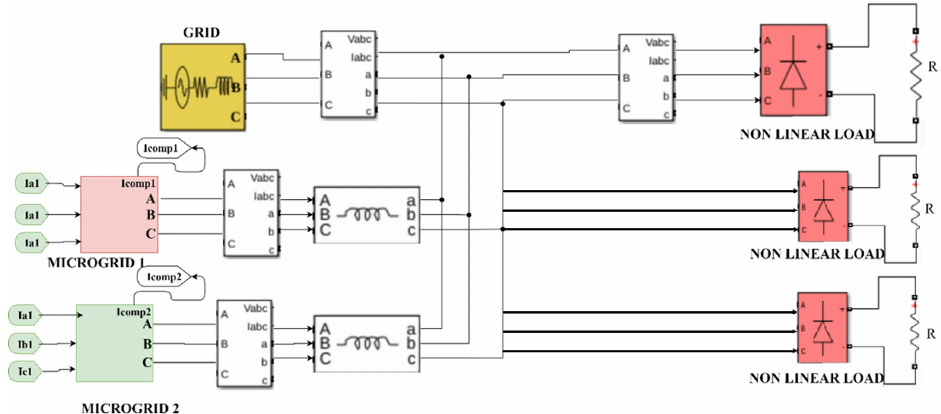
Figure 13. MATLAB simulation of the proposed system with unbalanced non-linear load.